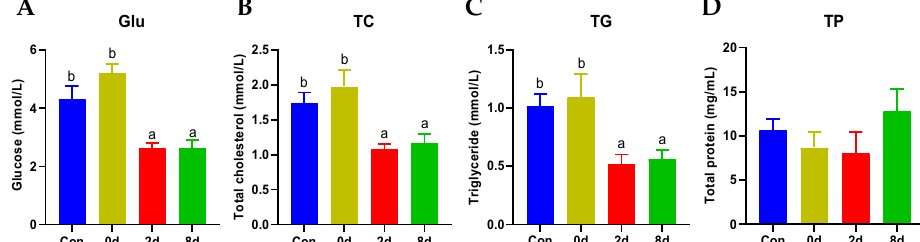
Figure 1. Effects of chronic hypothermia on plasma biochemical parameters of freshwater drum. ( A ) Glucose, Glu; ( B ) Total cholesterol, TC; ( C ) Triglyceride, TG; ( D ) Total protein, TP. Data were calculated by one-way ANOVA analysis with SPSS 23.0 (IBM SPSS Statistics, Version 23.0, Armonk, NY, USA). The significant differences are considered to exist when p < 0.05, and marked with different letters. Results were expressed as mean ± SEM, n = 6.